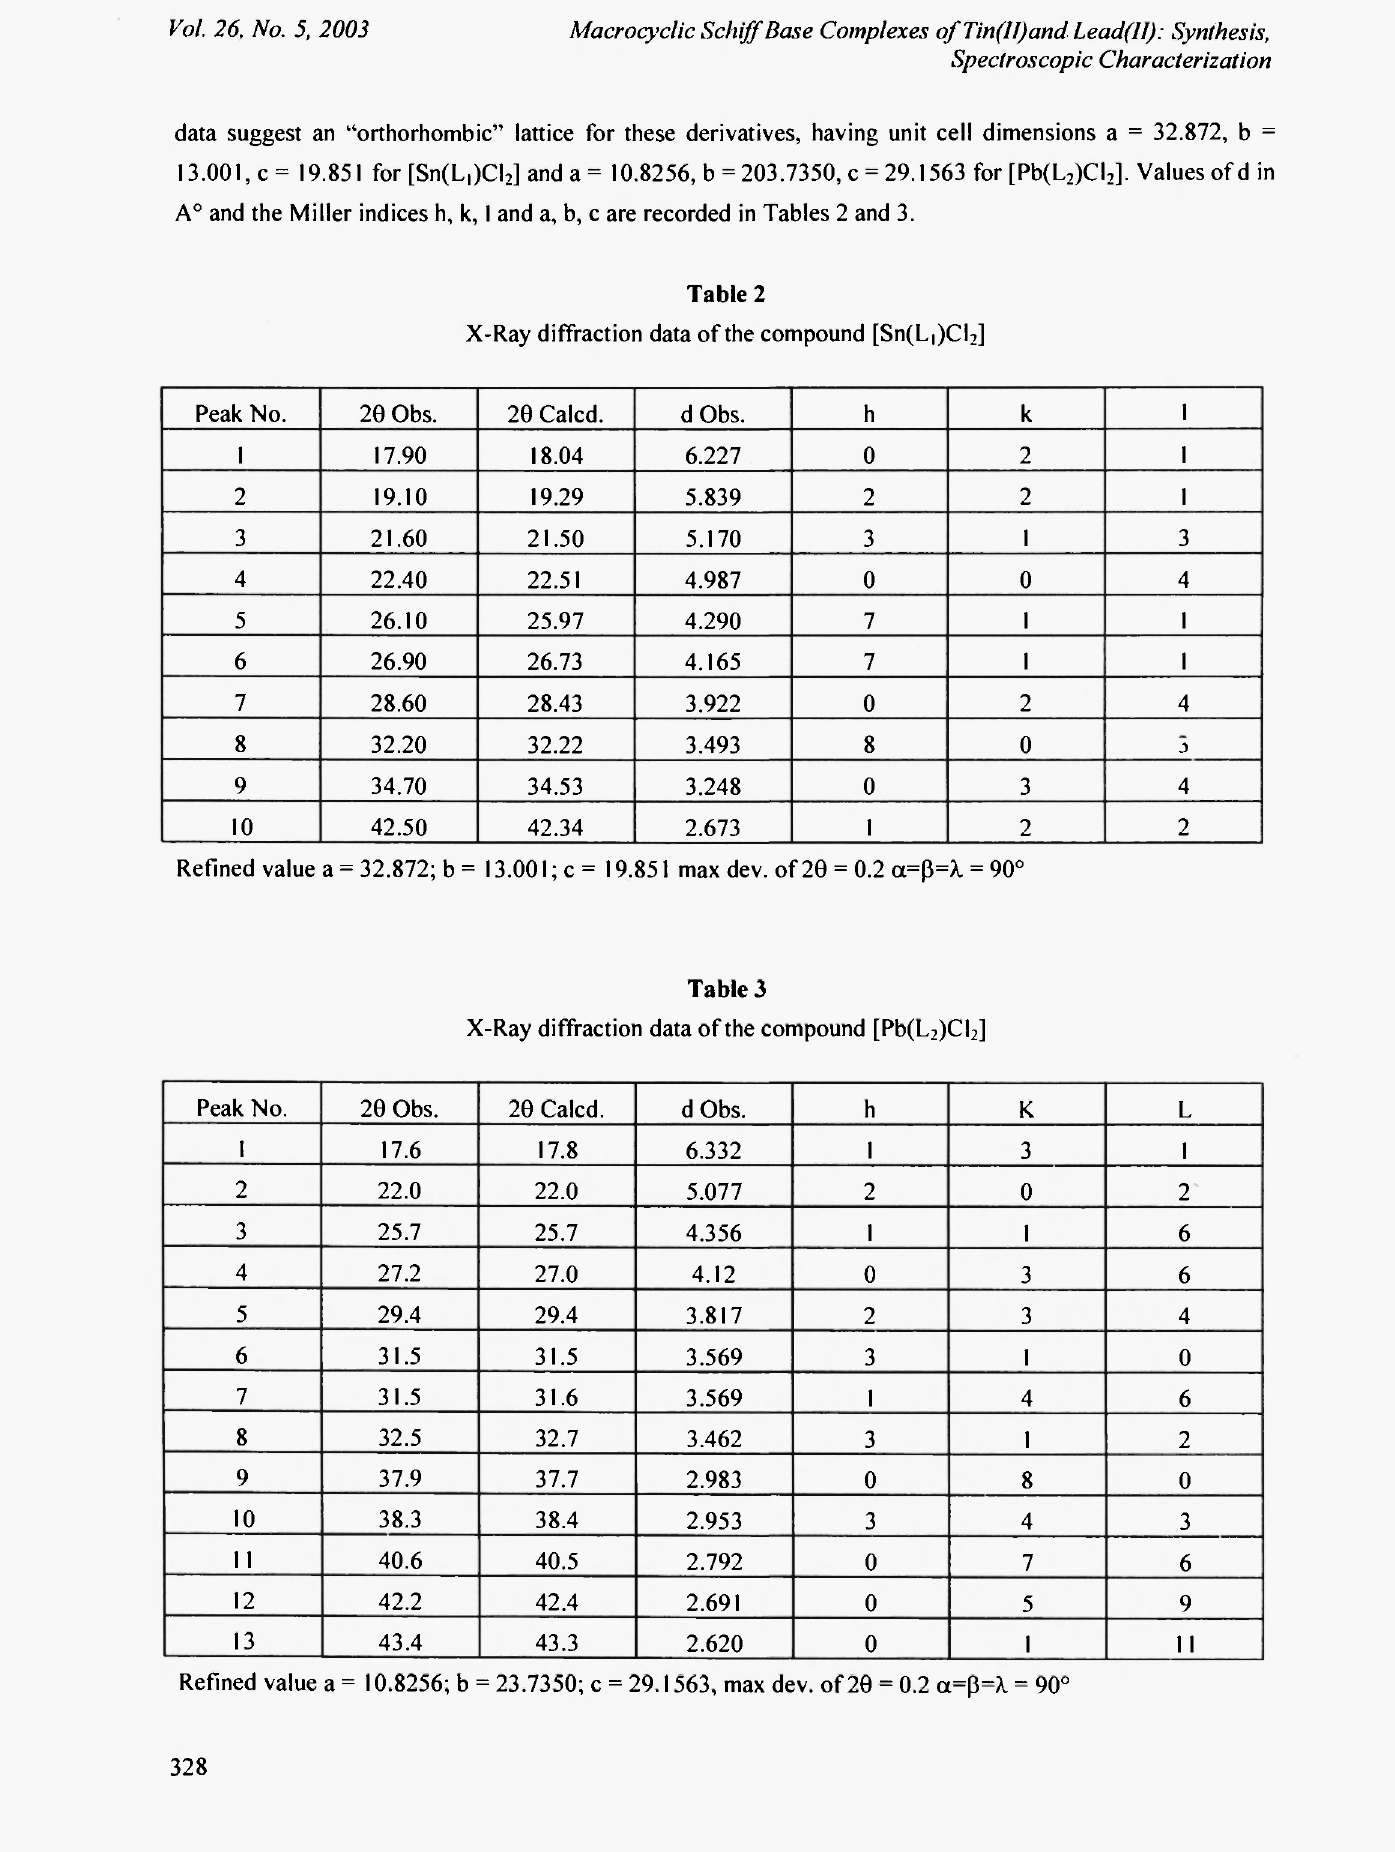
X-Ray diffraction data of the compound [Pb(L 2 )Cl 2